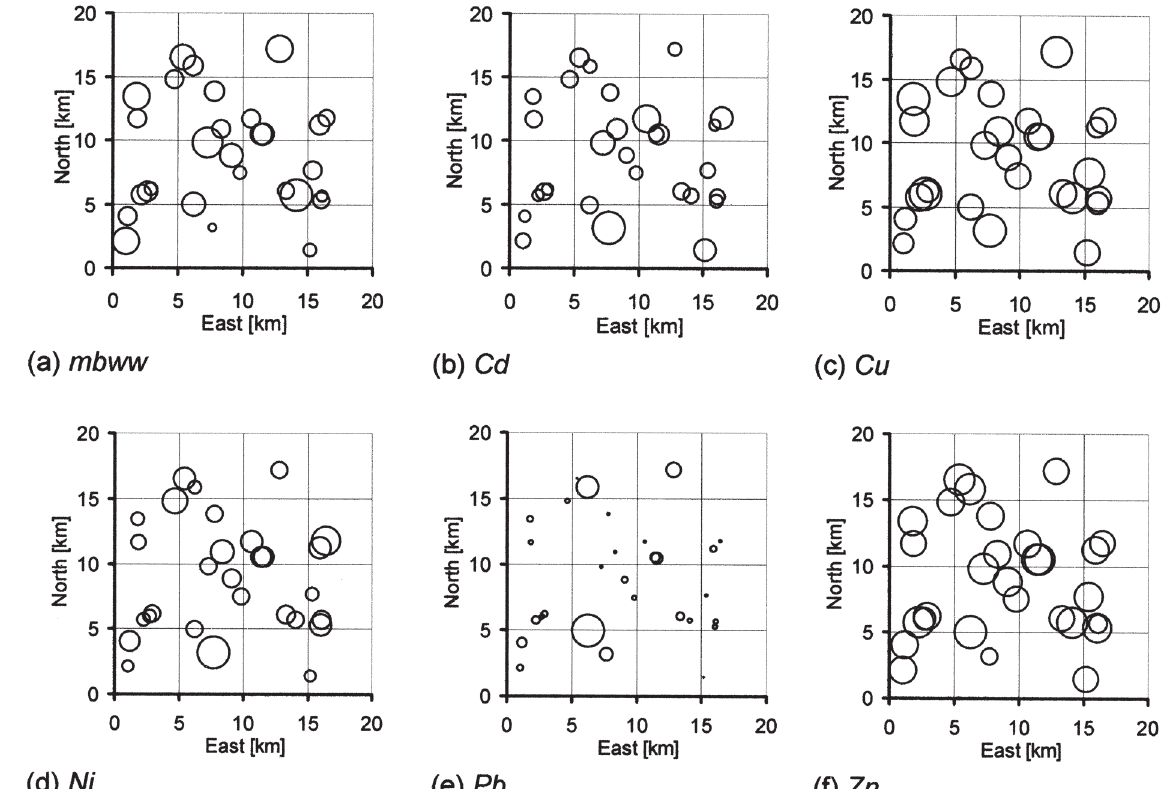
Fig . 2. – spatial distributions (post plots) of sampling stations within Box a (Fig. 1). Point sizes are relative to the measured values of (a) mbww (mean body wet weight of shrimps per sample in g), (b) Cd , (c) Cu , (d) ni , (e) Pb and (f) Zn in Crangon crangon (mg kg -1 dW,